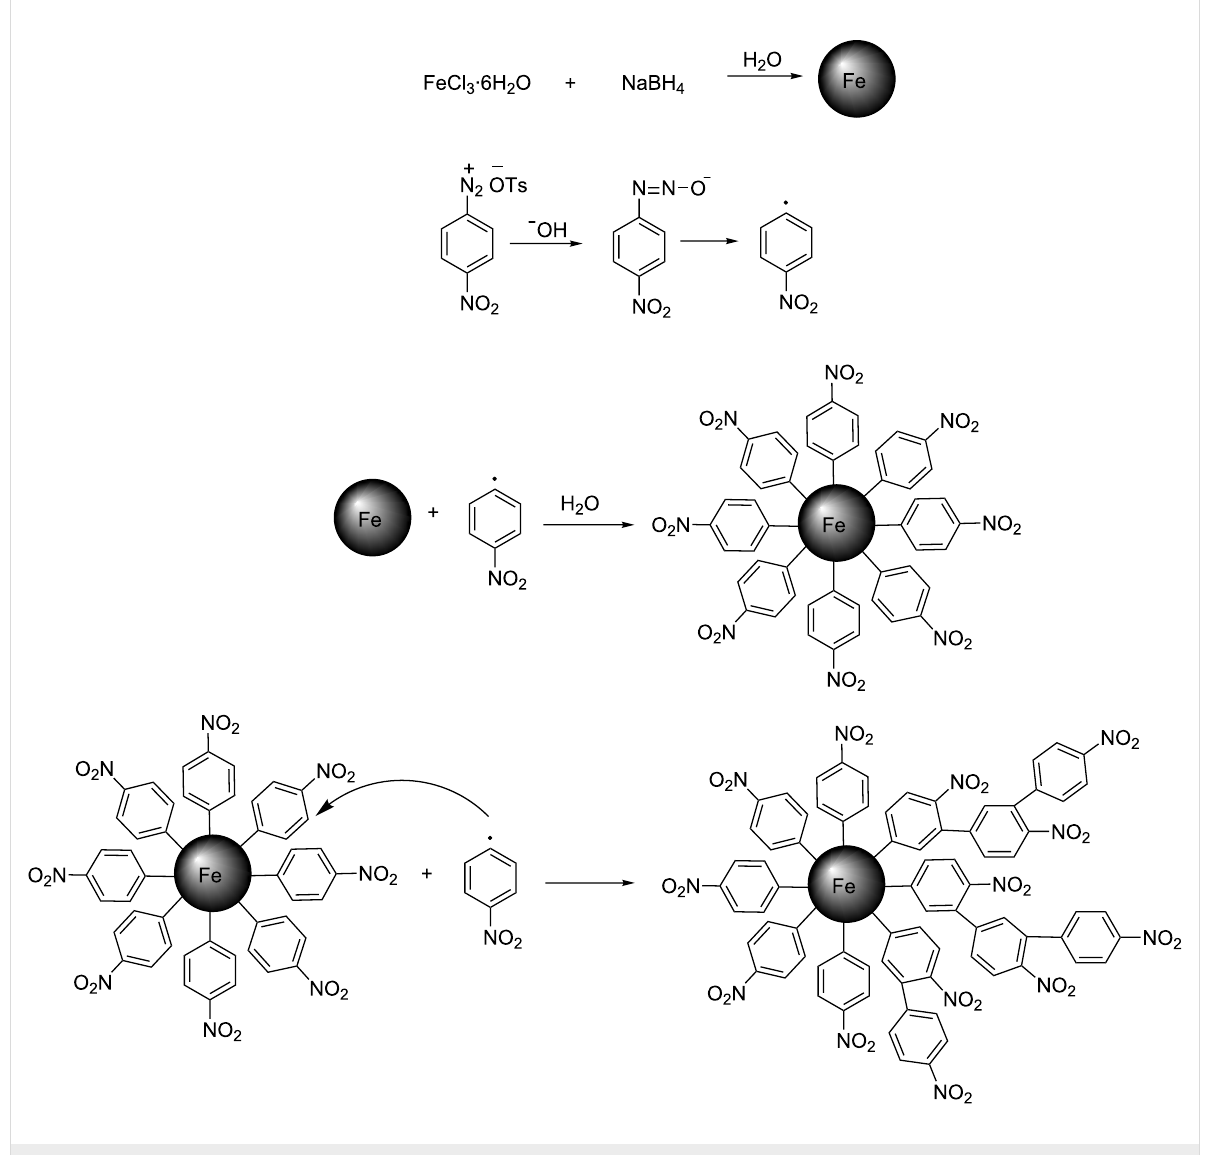
Scheme 1: Proposed mechanism of in situ modification of ZVI NPs using